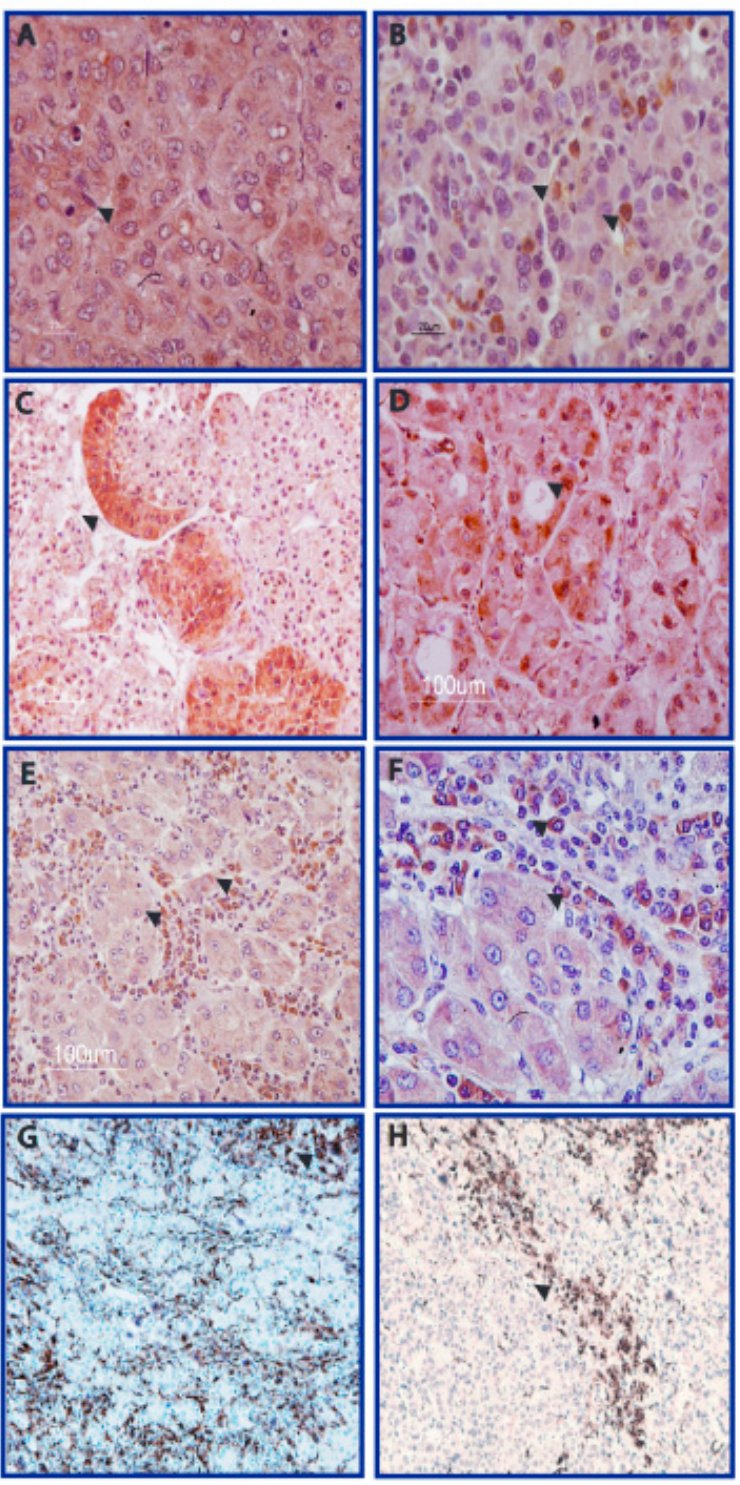
Figure 1. AFB1 staining in human neoplastic hepatocytes and in tumor-infiltrating cells. ( A – D ). Representative cases of AFB1-adducts immunostaining in neoplastic hepatocytes and tumor-infiltrating cells displaying a variable degree and extension. ( E , F ): Tumor-infiltrating cells positive to AFB1-adducts were further characterised by CD68 immunostaining ( G , H ), confirming their monocytic origin. Scale bars are reported. Magnification: ( A , B ): 40 × ; ( C ): 20 × ; ( F ): 40 × ; ( D – H ): 10 ×.